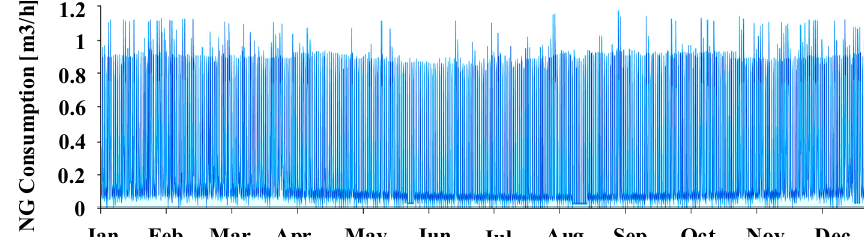
Figure 15. Hourly output power of thermal power suppliers: ( a ) gas boiler; ( b ) FC.